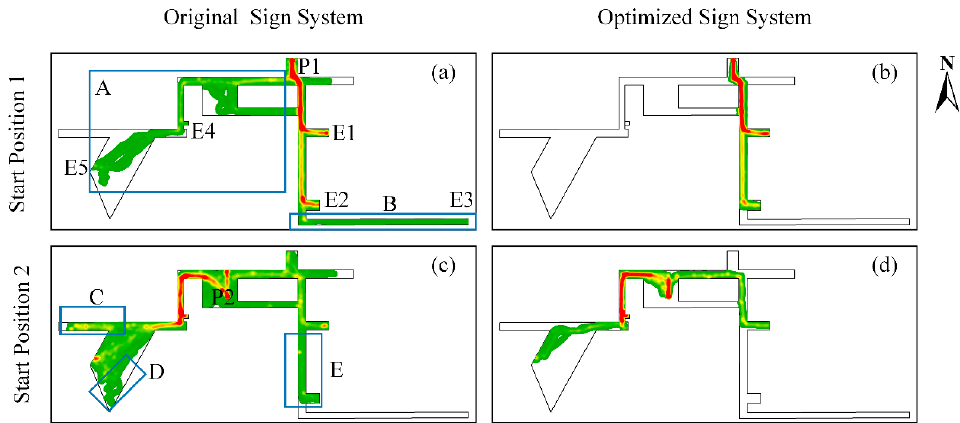
Figure 14. Comparison of trajectory hotspot charts before and after optimization of the VR experiments. ( a ) Experimental environment with the original sign system, where participants start from P1; ( b ) Experimental environment with the optimized sign system, where participants start from P1; ( c ) Experimental environment with the original sign system, where participants start from P2; ( d ) Experimental environment with the optimized sign system, where participants start from P2.